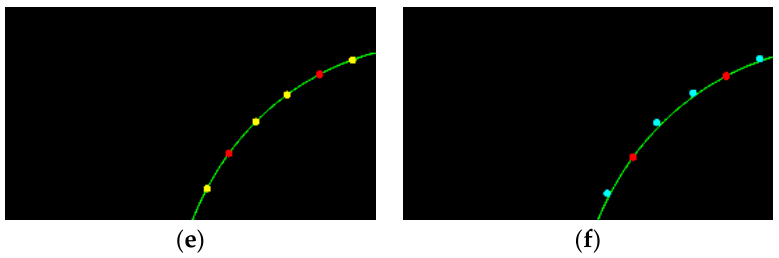
Figure 15. Each stage output of dimension measurement processing: ( a ) The image I from camera capture; ( b ) the binarization and inverse image I b ; ( c ) internal contour of the O-ring; ( d ) approximate points A ; ( e ) schematic diagram of the divided contour; ( f ) result of the converted cubic Bézier control points.